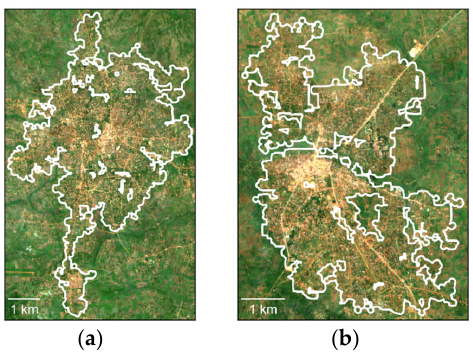
Figure 5. GRID3 non-refugee settlement boundaries (shown in white) at ( a ) Adjumani and ( b ) Kitgum with background true-color Sentinel-2 imagery from 2019. Kitgum with background true-color Sentinel-2 imagery from